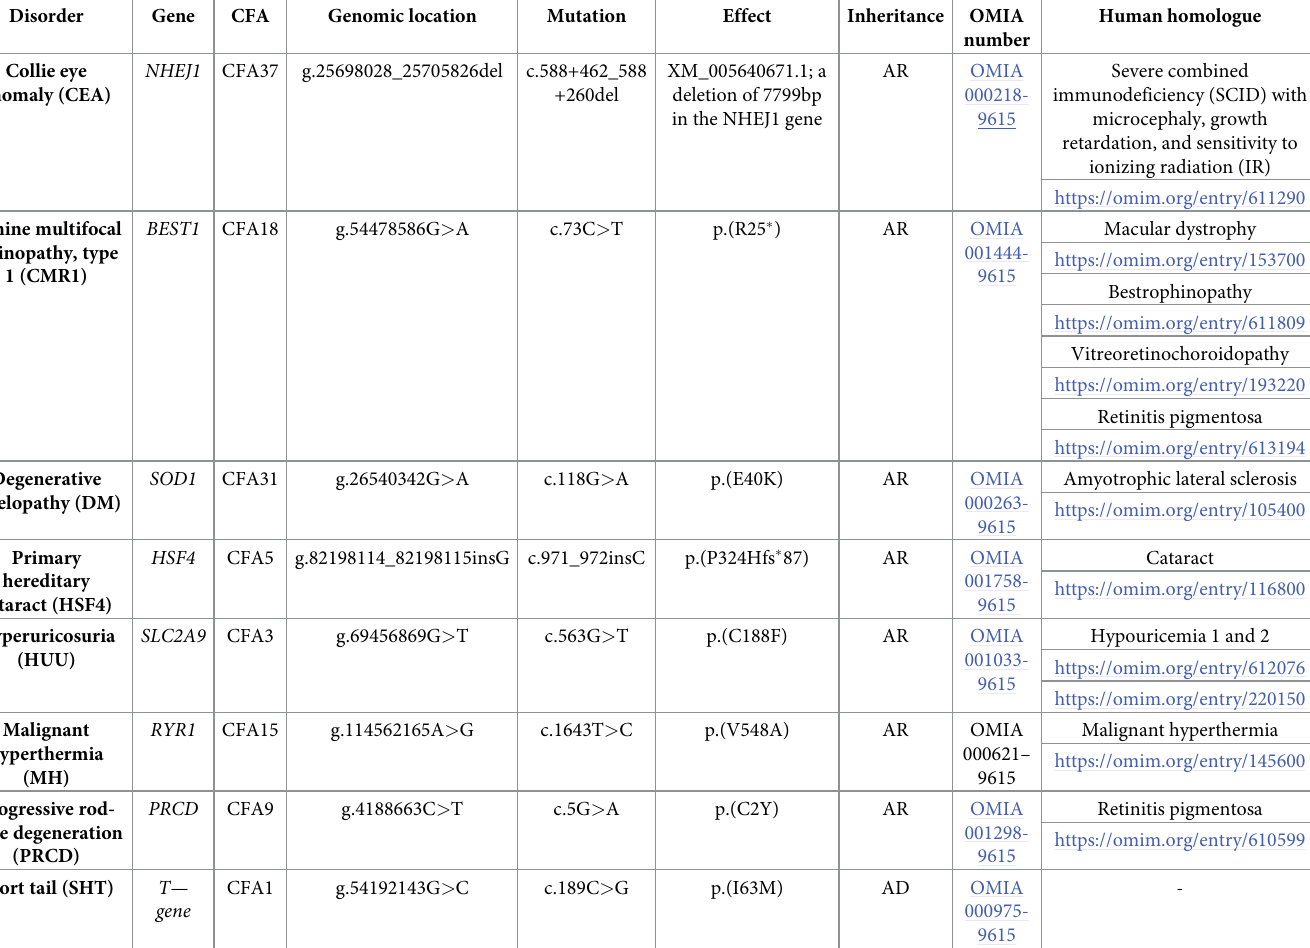
Table 1. An overview of six genetic disorders with their corresponding gene, chromosome number, genomic location, mutation, effect, inheritance, OMIA number and human homologue. Disorder